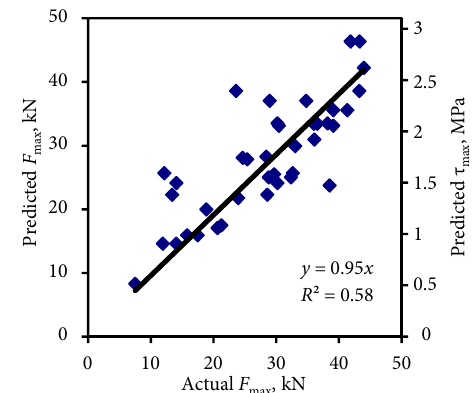
Fig. 4. Prediction of F max for independent query test dataset